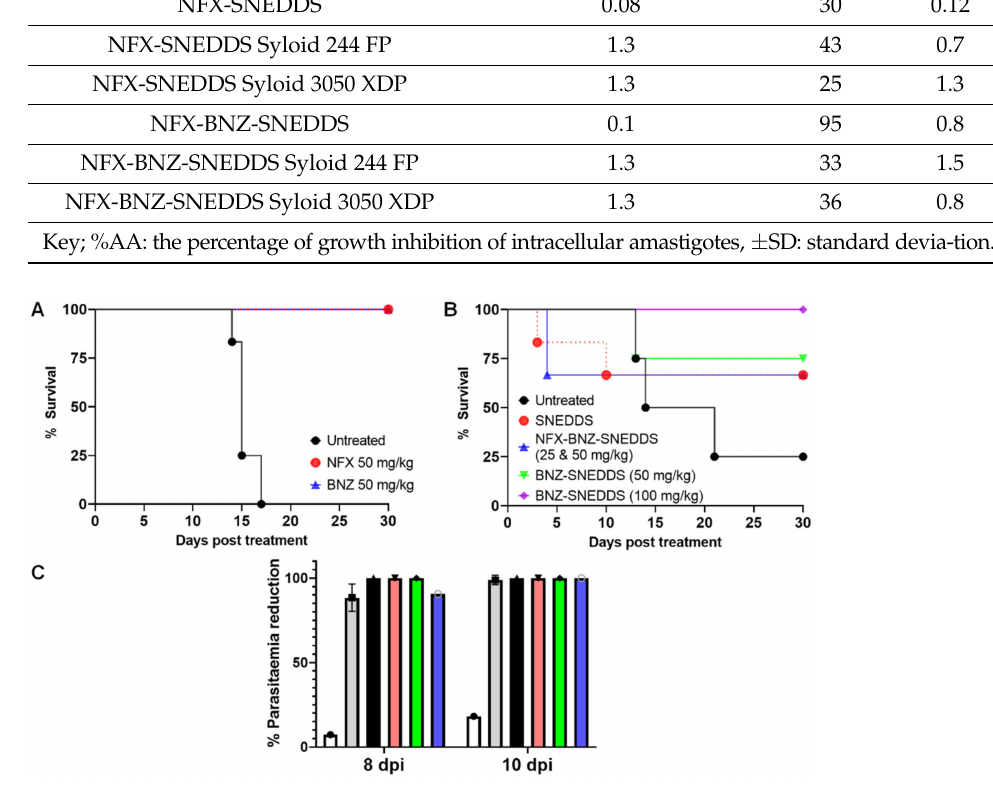
Figure 8. ( A ): Kaplan-Meier survival plot comparing the untreated control (black line) to oral suspen- sions of NFX (50 mg kg − 1 , red line) and BNZ (50 mg kg − 1 , blue line) administered orally over 5 days ( n = 6). Survival at day 30 post-treatment is significant for both NFX and BNZ groups ( p < 0.0001, Kruskal Wallis test, 95% level of significance). ( B ): Kaplan-Meier survival plot comparing the un- treated control (black line) to orally administered blank SNEDDS (red line), NFX-BNZ-SNEDDS (25 and 50 mg kg − 1 respectively, blue line), BNZ-SNEDDS (50 mg kg − 1 , green line), BNZ-SNEDDS (100 mg kg − 1 , purple line) over 5 days ( n = 6). Survival at day 30 post-treatment is significant for both BNZ-SNEDDS groups versus the untreated control ( p :0.0045 and p : < 0.0001 for 50 and 100 mg kg − 1 re- spectively) and vs. NFX-BNZ-SNEDDS ( p : 0.0004 and p < 0.0001 for 50 and 100 mg kg − 1 respectively) (Kruskal Wallis test, 95% level of significance). ( C ): Parasitaemia levels of surviving animals during the acute infection period (days 8, 10 post-infection) in BALB/c male mice infected with 10,000 blood- stream trypomastigotes of T. cruzi . Mice were randomly split into groups of six to ensure that a 50% difference in parasitic load can be detected with 80% confidence. Mice received five doses of formula- tions daily starting at day 5 post-infection. Parasitaemia was determined by counting the number of trypomastigotes in 5 µ L of fresh blood collected from the tail (means ± SEMs). Groups were treated with blank SNEDDS (white column), NFX (50 mg/kg/day, grey column) and BNZ (50 mg/kg/day, black column), BNZ-SNEDDS (50 mg/kg/day, salmon column), BNZ-SNEDDS (100 mg/kg/day, green column), and NFX-BNZ-SNEDDS (25 and 50 mg/kg/day respectively, blue